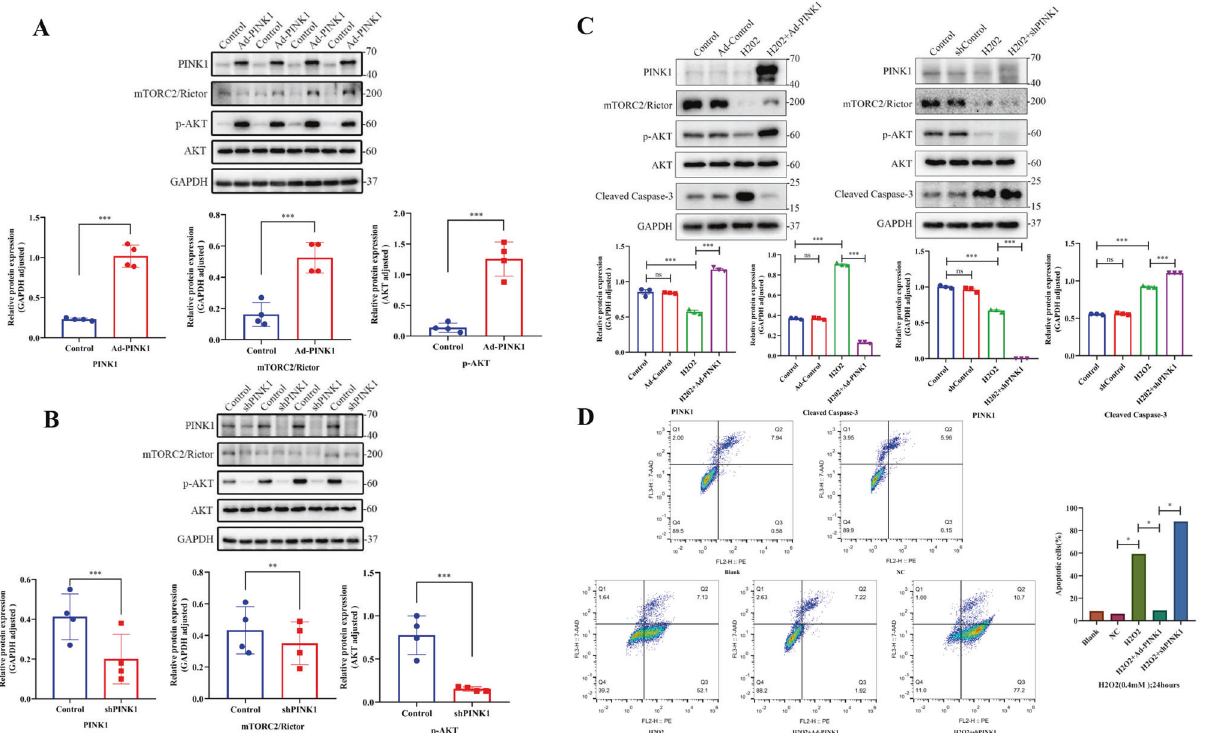
Fig. 4 Mechanism of PINK1-mediated caspase-3-mediated apoptosis. A Changes in mTORC2/Rictor and p-AKT expression levels, detected by western blot analysis in PINK1-overexpressed cells for 72 h. B L02 cells were transduced with PINK1 shRNA; the protein levels of mTORC2/ Rictor and p-AKT were examined and analyzed by Image J. C Effect of PINK1 overexpression or knockdown on caspase-3-mediated apoptosis in the H 2 O 2 -induced cell model, detected by western blotting and analyzed with the Image J software. D Flow cytometry further con fi rmed these results. * P < 0.05; ** P < 0.01; *** P < 0.001; **** P < 0.0001; ns not signi fi